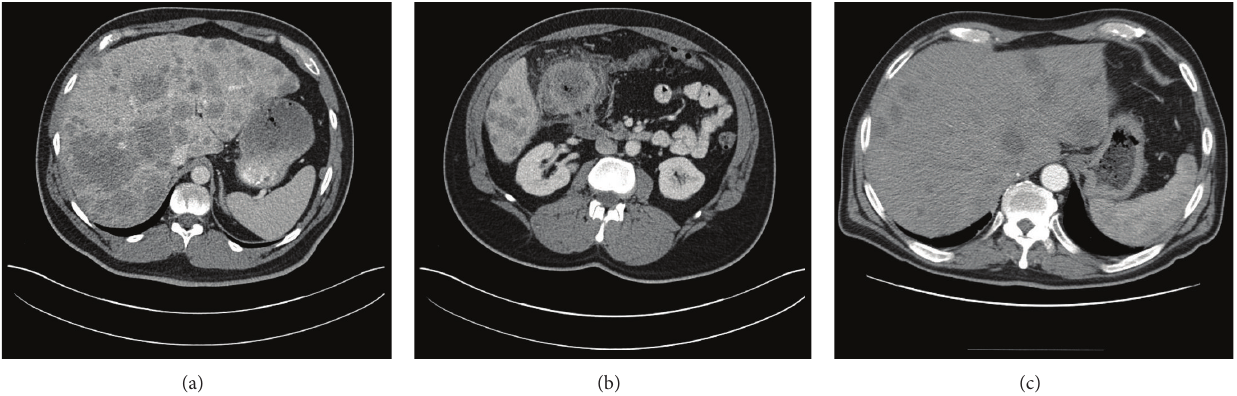
Figure 1: (a) CT scan of the abdomen showing innumerable liver metastases in a patient (Case 1) with colorectal cancer (a) and the primary mass in the ascending colon (b). Image (c) shows a similar scan with multiple liver metastases in another patient (Case 2) with mCRC.